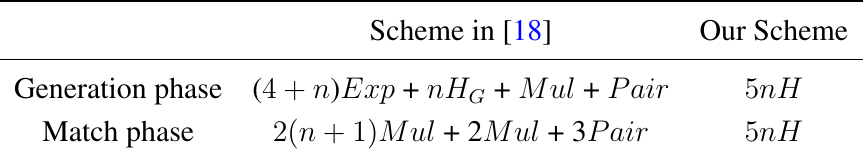
Table 4. The comparison of the computational